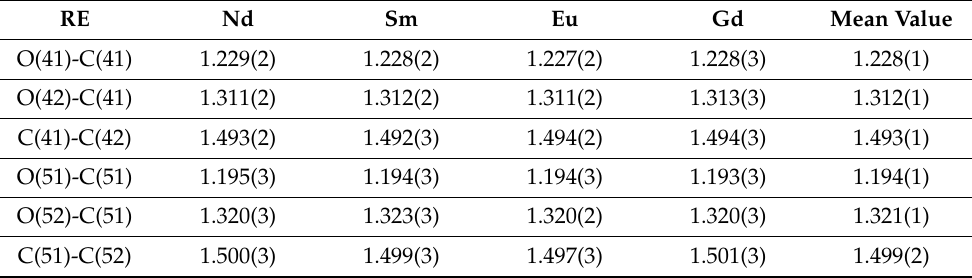
Table 4. Bond lengths [Å] within the different acetic acid molecules of the RE(OAc) 3 · 2AcOH structure type with mean values and standard deviations in brackets.